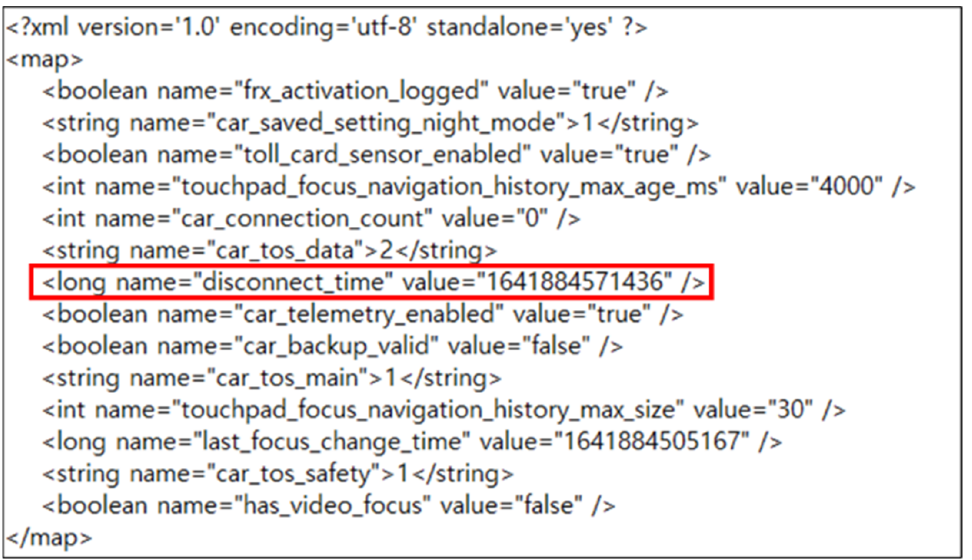
Figure 6. The disconnect_time field inside the carservice.xml file. The red frame indicates the disconnection time (disconnect_time).